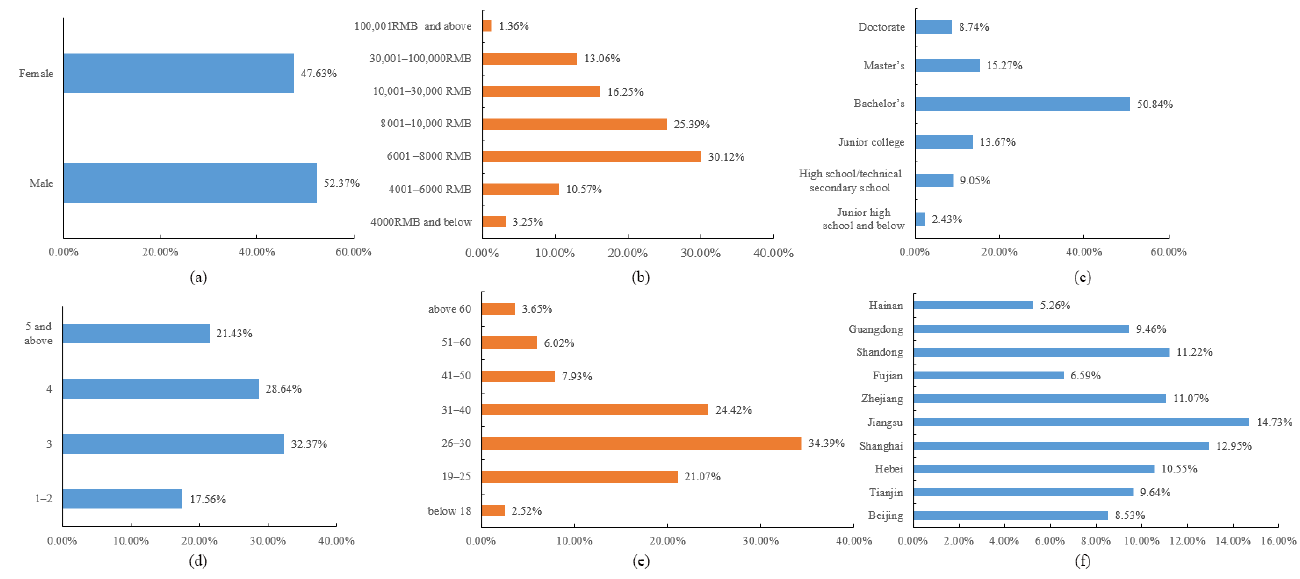
Figure 3. Demographic characteristics of the sample (N = 1732): ( a ) gender, ( b ) monthly income, ( c ) educational level, ( d ) family member, ( e ) age, and ( f ) province.